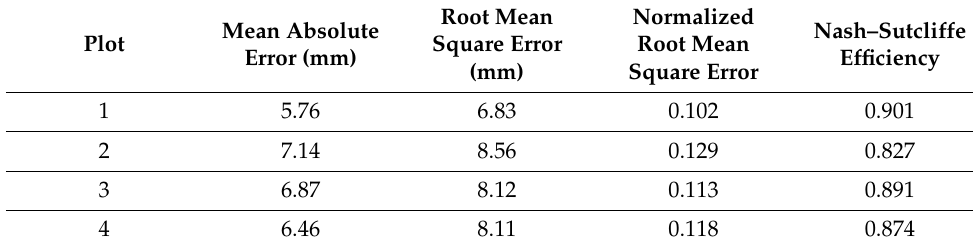
Table 7. Statistics obtained from validating the model using actual values of FC and PWP.